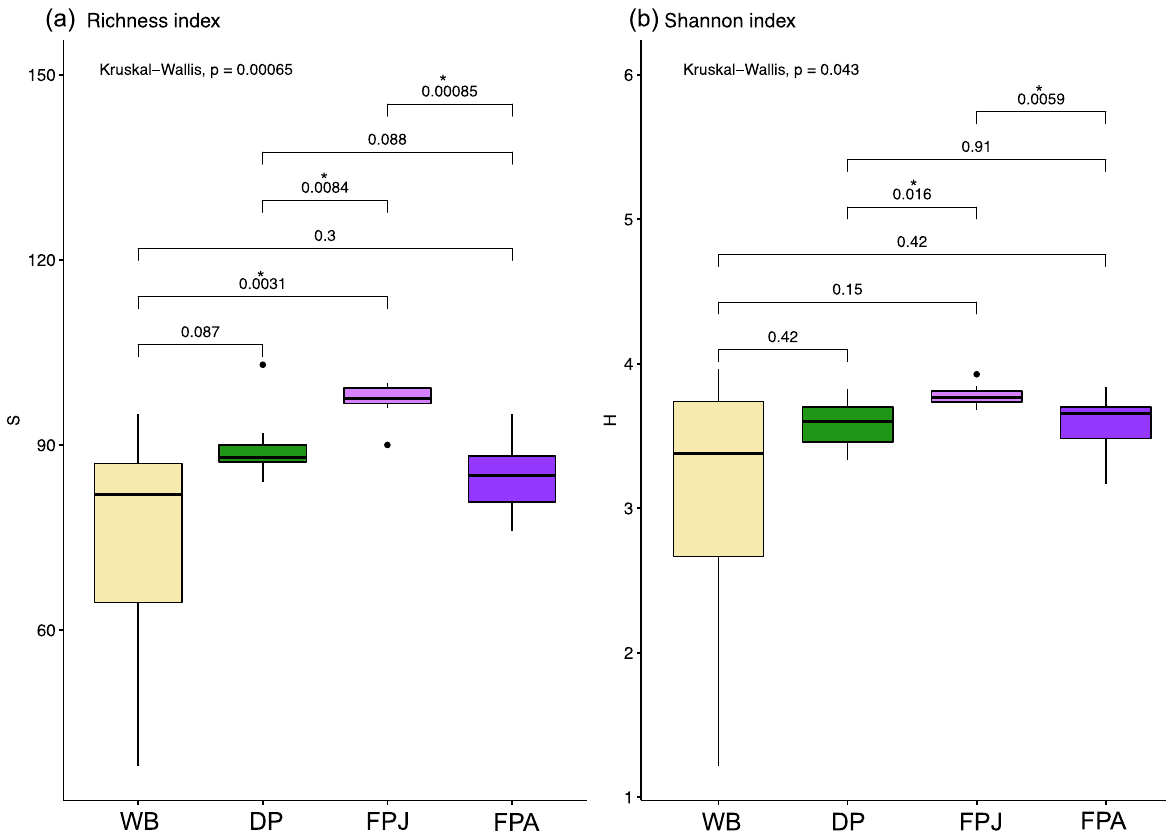
Fig. 5 Alpha-diversity. (a) Richness (S) and (b) Shannon (H) indices, for wild boar (WB), domestic pig (DP), and juvenile (FPJ) and adult (FPA) feral pigs. Asterisks indicate significant differences between